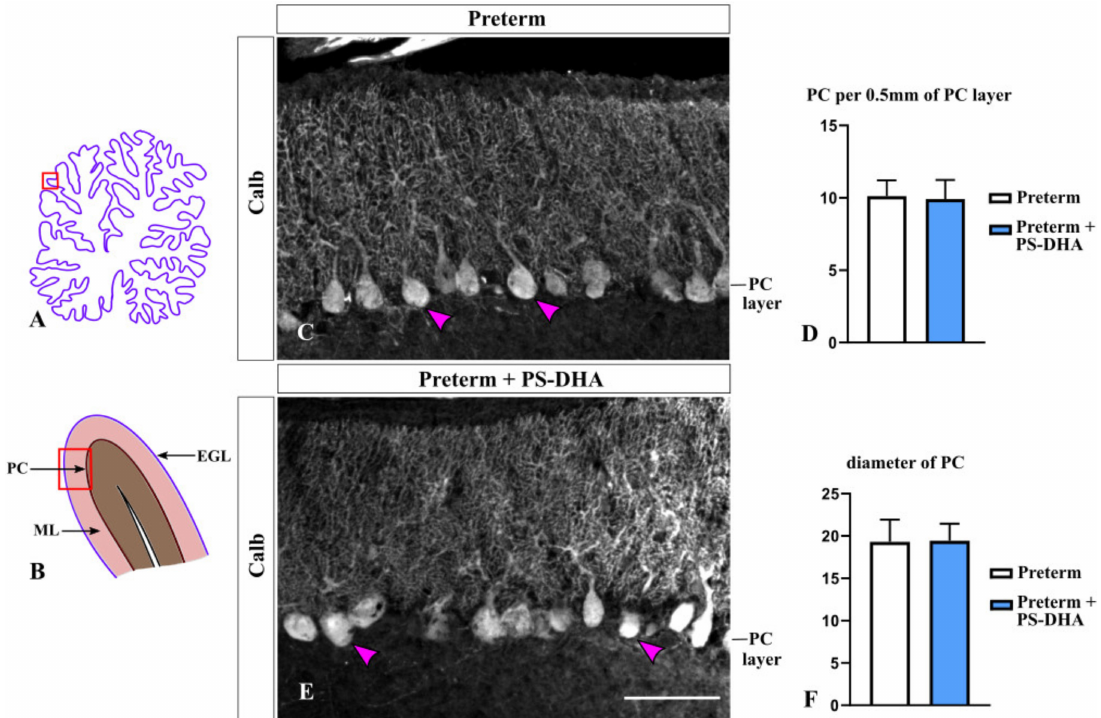
Figure 4. PS-DHA does not a ff ect the density or size of Purkinje cells in the preterm pig cerebellum. ( A , B ) Schematic of midsagittal section of the newborn pig cerebellum ( A ). Panel B shows a higher magnification of the region boxed in panel A. EGL, external granule cell layer, ML, molecular layer, PC, Purkinje cell layer. Panels C and E display sections immunostained against Calbindin, photographed under 10 × magnification, which correspond to the region shown by the box in panel B. ( C , E ) Arrowheads point to Purkinje cells. ( D , F ) Quantification analysis revealed a similar density and diameter of Purkinje neurons in preterm pigs that received PS-DHA and the control group of preterm pigs. n = 5 pigs per group. Scale bar: 100 µ